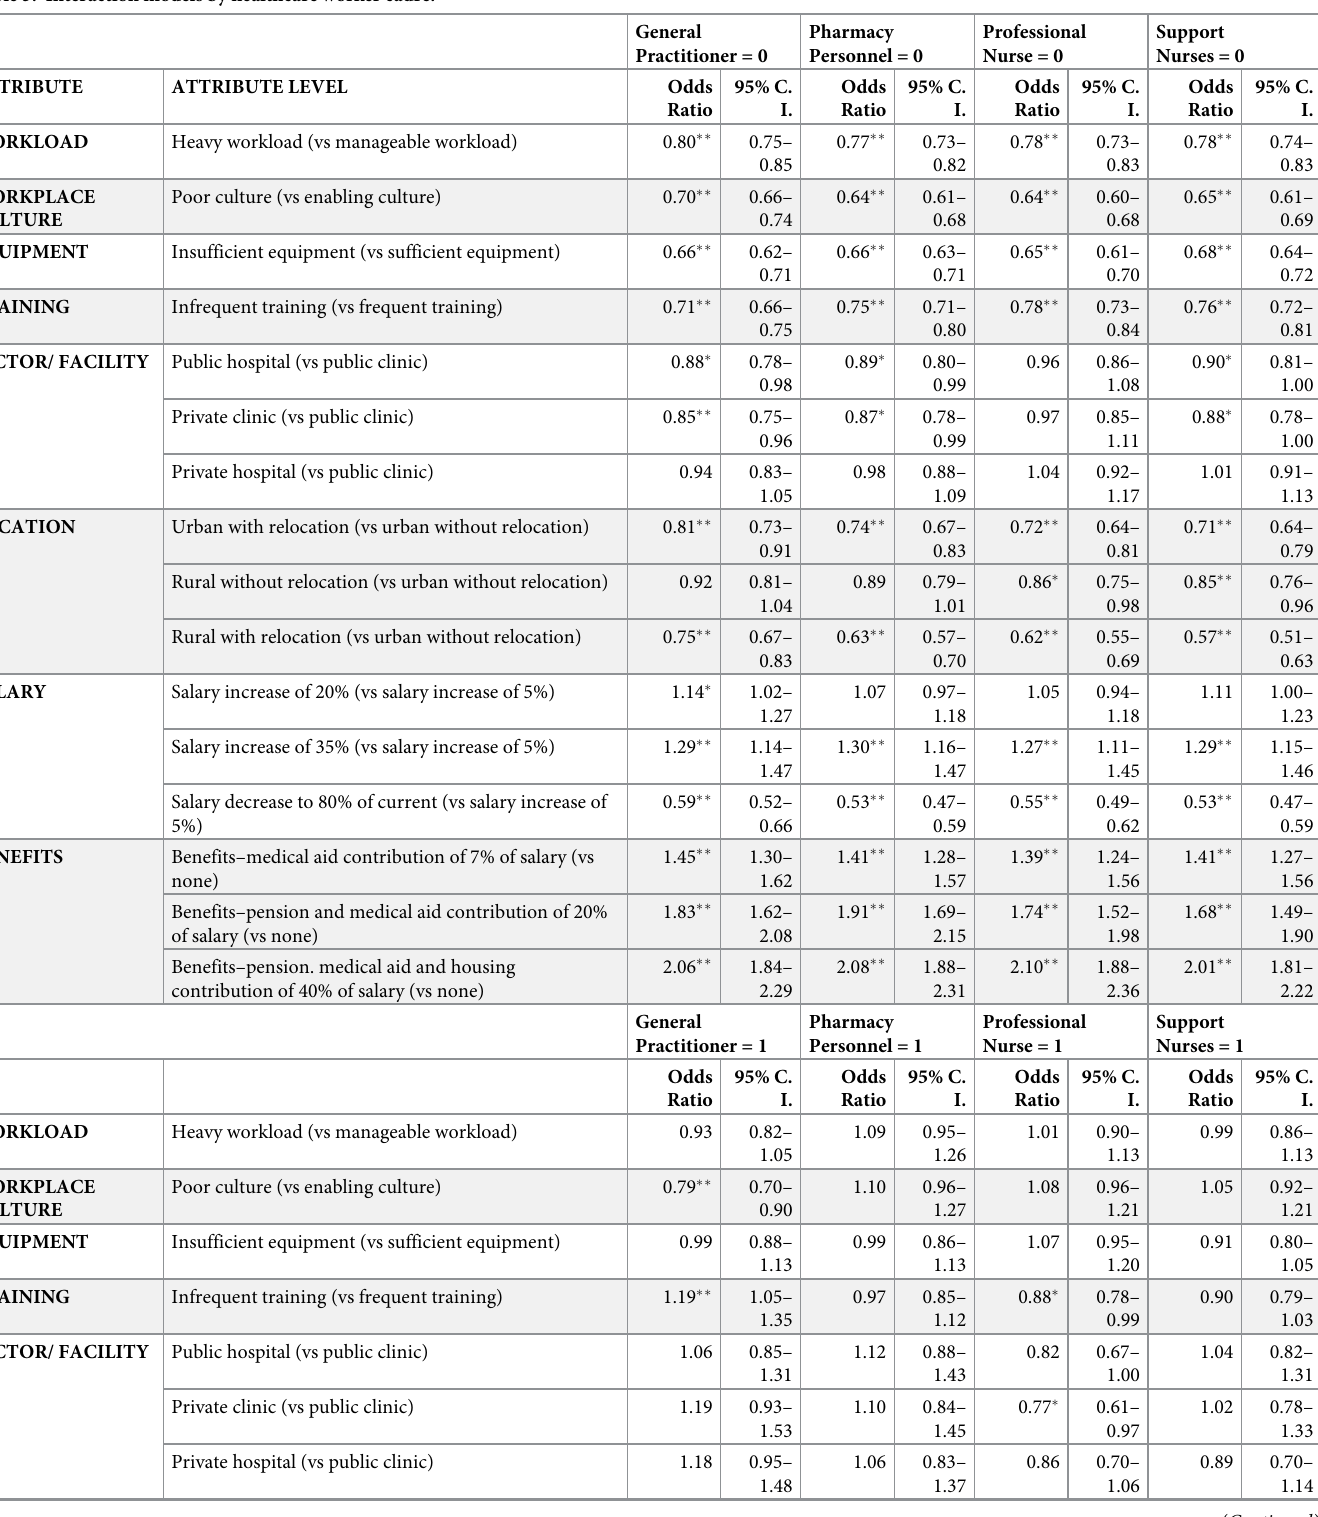
Table 5. Interaction models by healthcare worker